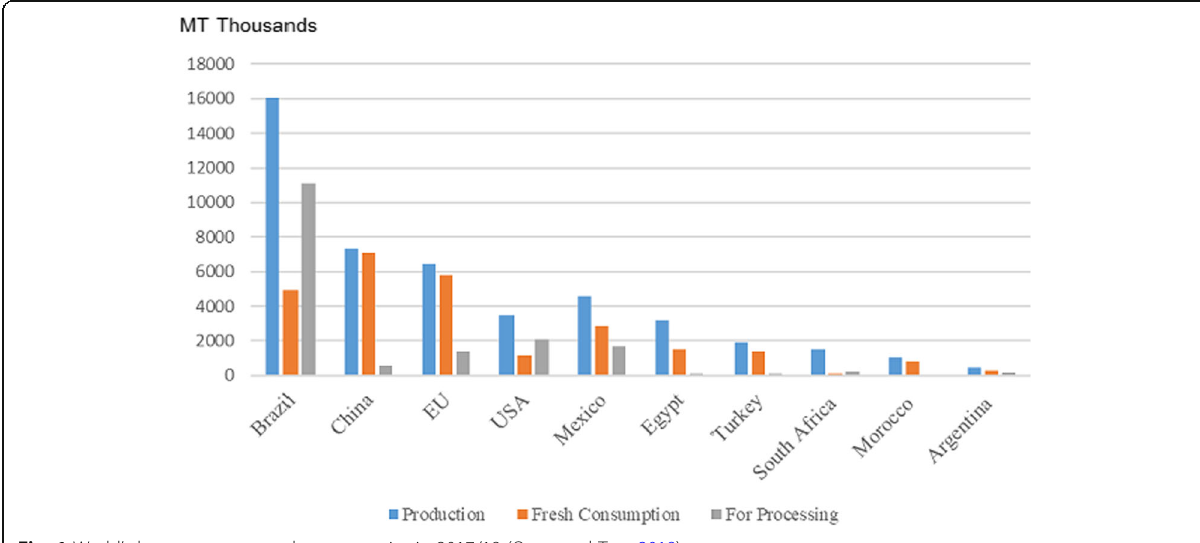
Fig. 1 World ’ s largest orange producer countries in 2017/18 (Omar and Tate